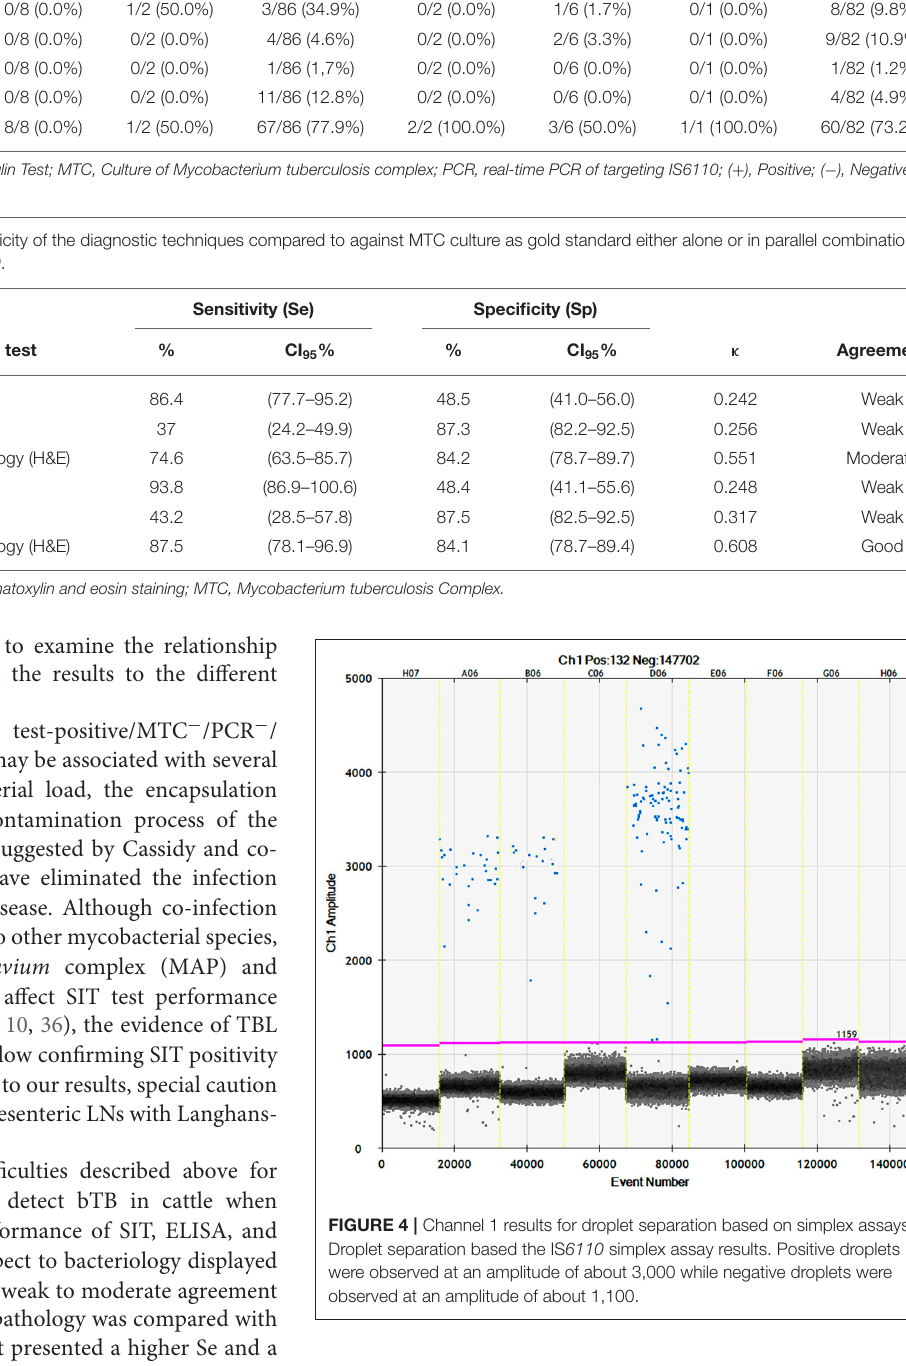
diagnostic tool which may help improving bTB diagnosis and disease